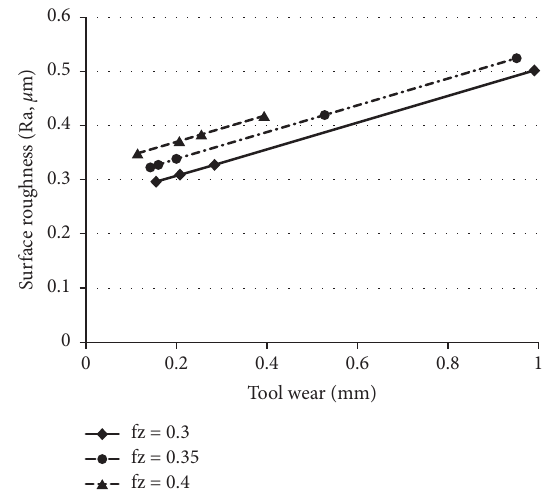
Figure 12: Trend of surface roughness